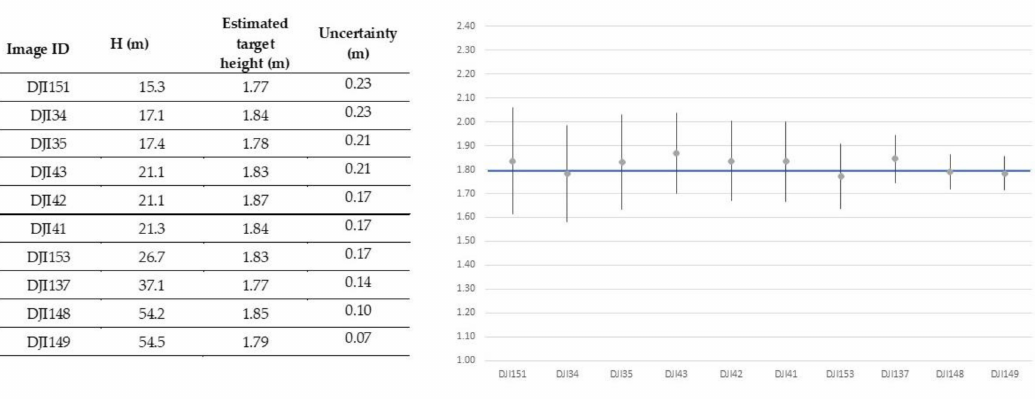
Figure 12. Subset of images with H higher than 15 m (see Tables 3 and 4). For each image, the‘estimated height and the uncertainty calculated using the function obtained in Figure 9e are reported. The estimated height and uncertainty are also reported graphically for each image (on the